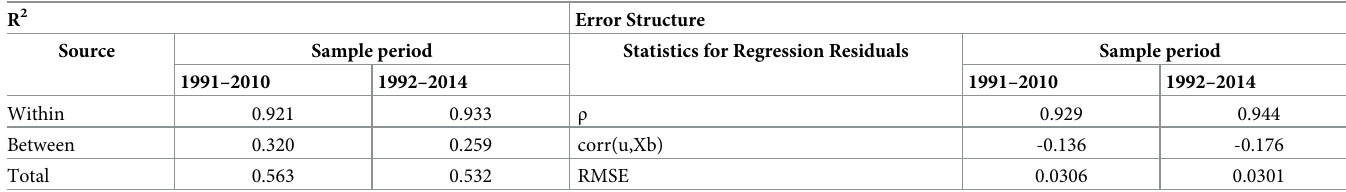
Table 2. R 2 and residual statistics for final regression results, 1992–2010, 1992–2014.